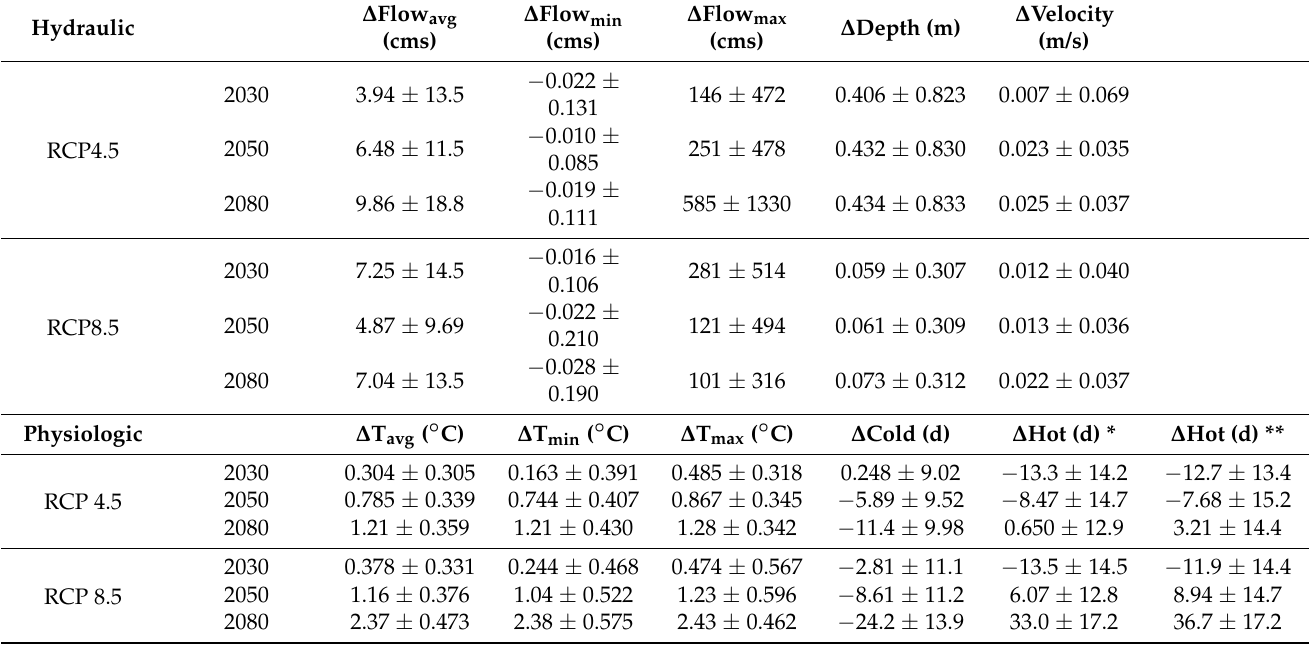
Changes in average environmental variables (Flow avg = annual average flow, Flow min = annual minimum flow, Flow max = annual maximum flow, Depth = annual depth, Ve- locity = annual velocity, WT avg = annual average water temperature, WT min = annual minimum water temperature, WT max = annual maximum water temperature, Cold = number of cold